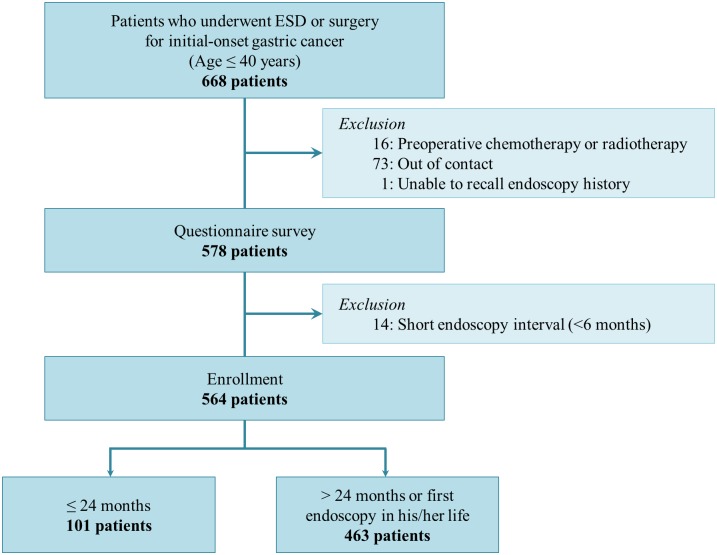
Flow diagram of the study design.